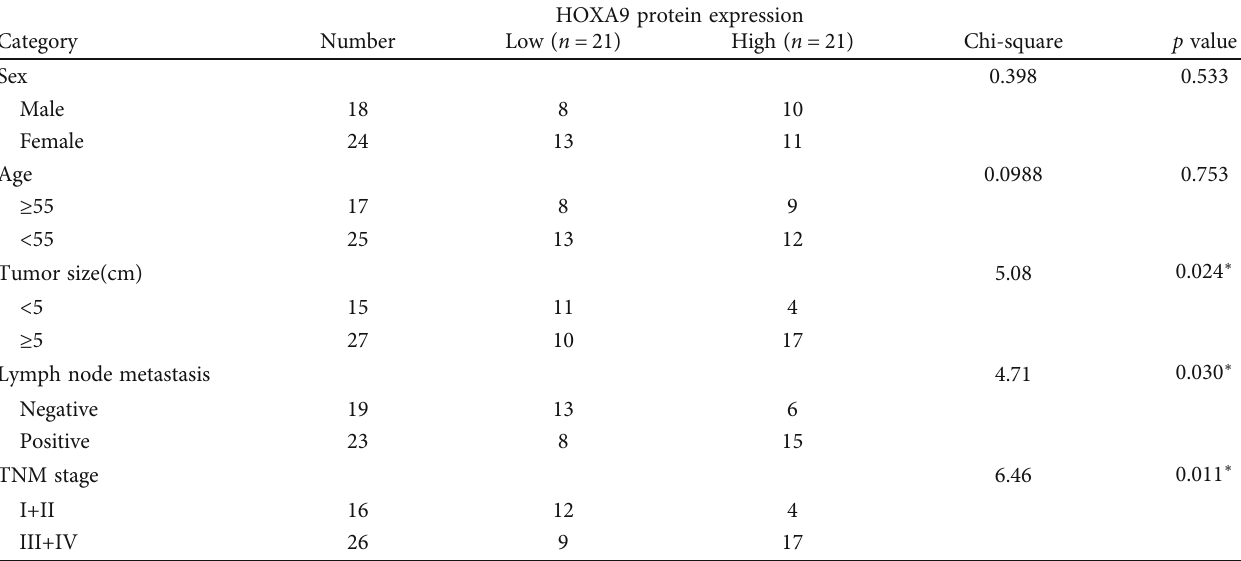
Table 2: Correlation of HOXA9 protein expression with clinical characteristics of CRC ( n = 42